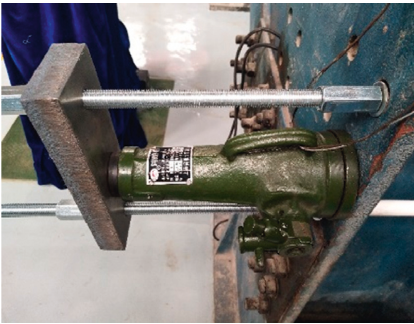
Figure 5: Jack apparatus.